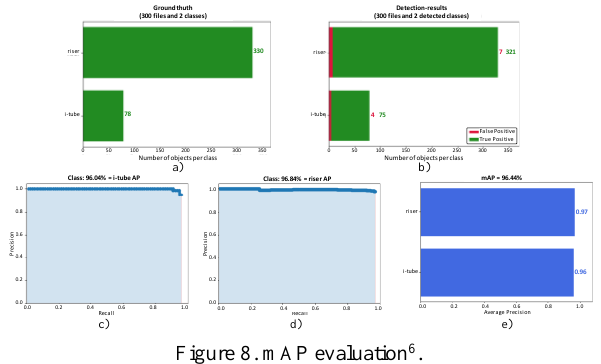
Figure 8. mAP evaluation 6 .